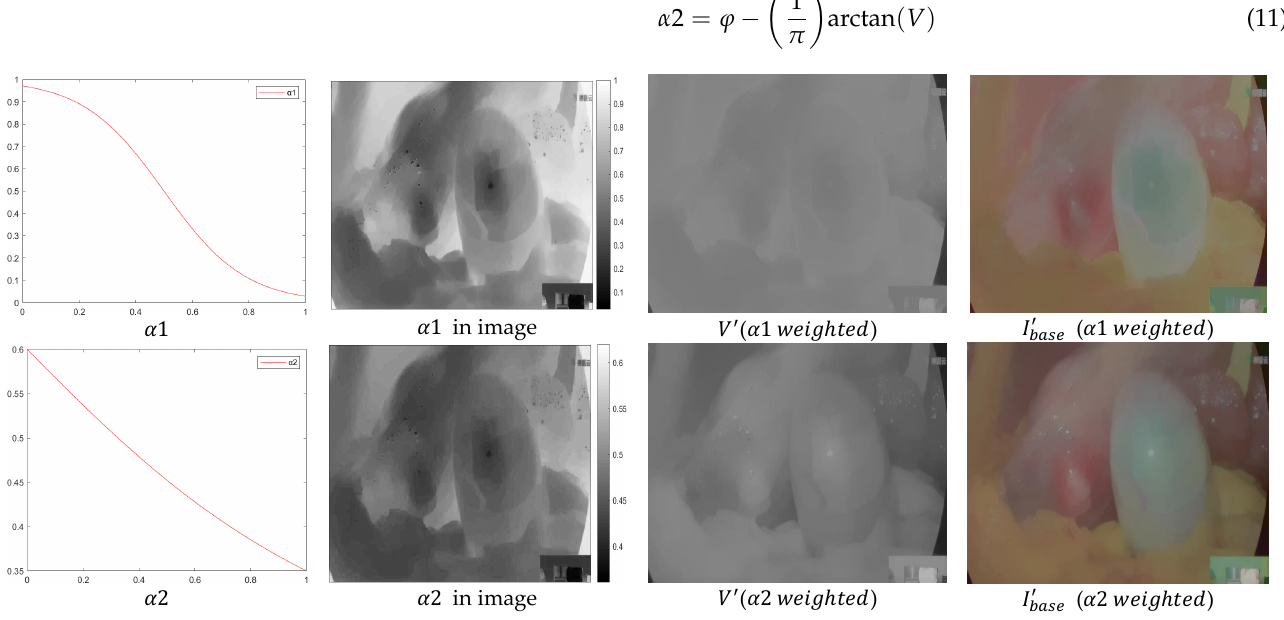
Figure 4. The function curves for 𝛾 values of 2.2, 2.5, and 2.8. The curve above y = x is V1 trans- formed with γ , and the curve below y = x is V2 transformed with γ . The red curve represents a γ value of 2.2, the green curve represents a γ value of 2.5, and the blue curve represents a γ value of 2.8.